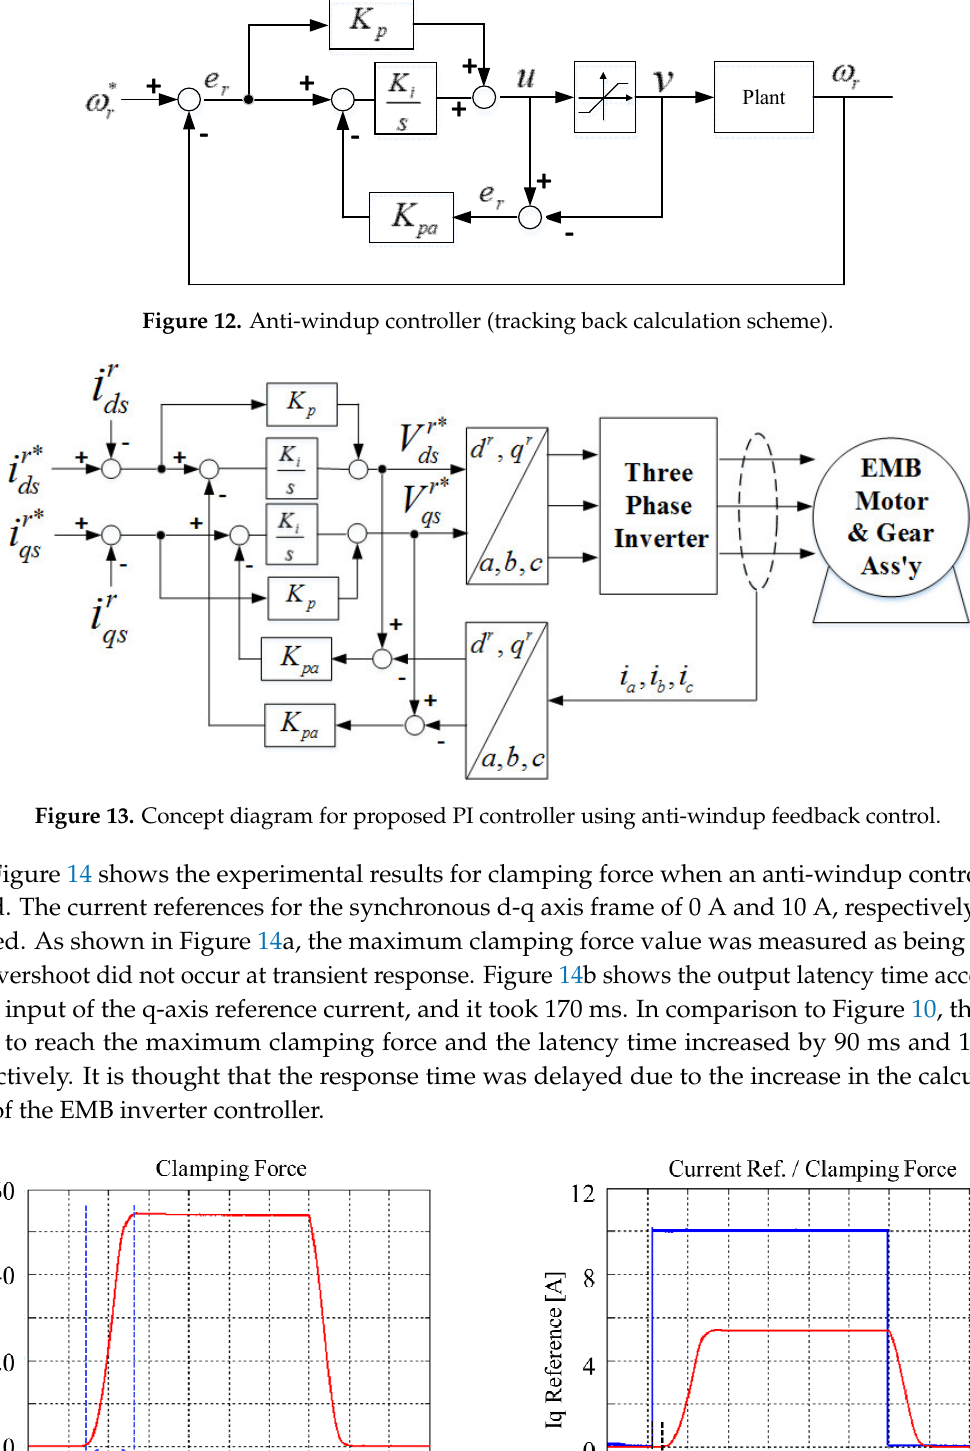
Figure 12. Anti-windup controller (tracking back calculation scheme).